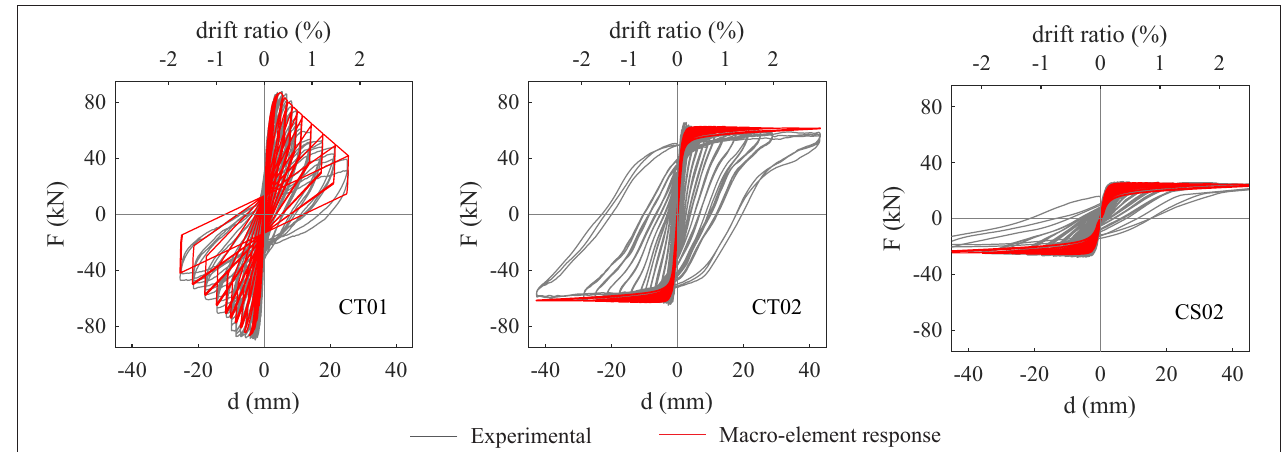
FIGURE 3 | Stone masonry building: calibration of the mechanical properties of the macroelements against three shear compression tests performed on masonry of the same typology as the prototype.